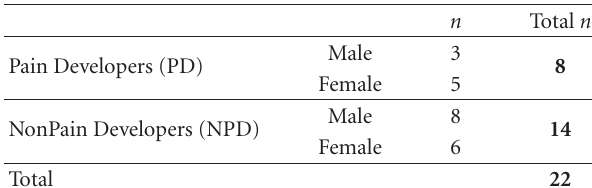
Table 2: Sample distribution among groups following participant